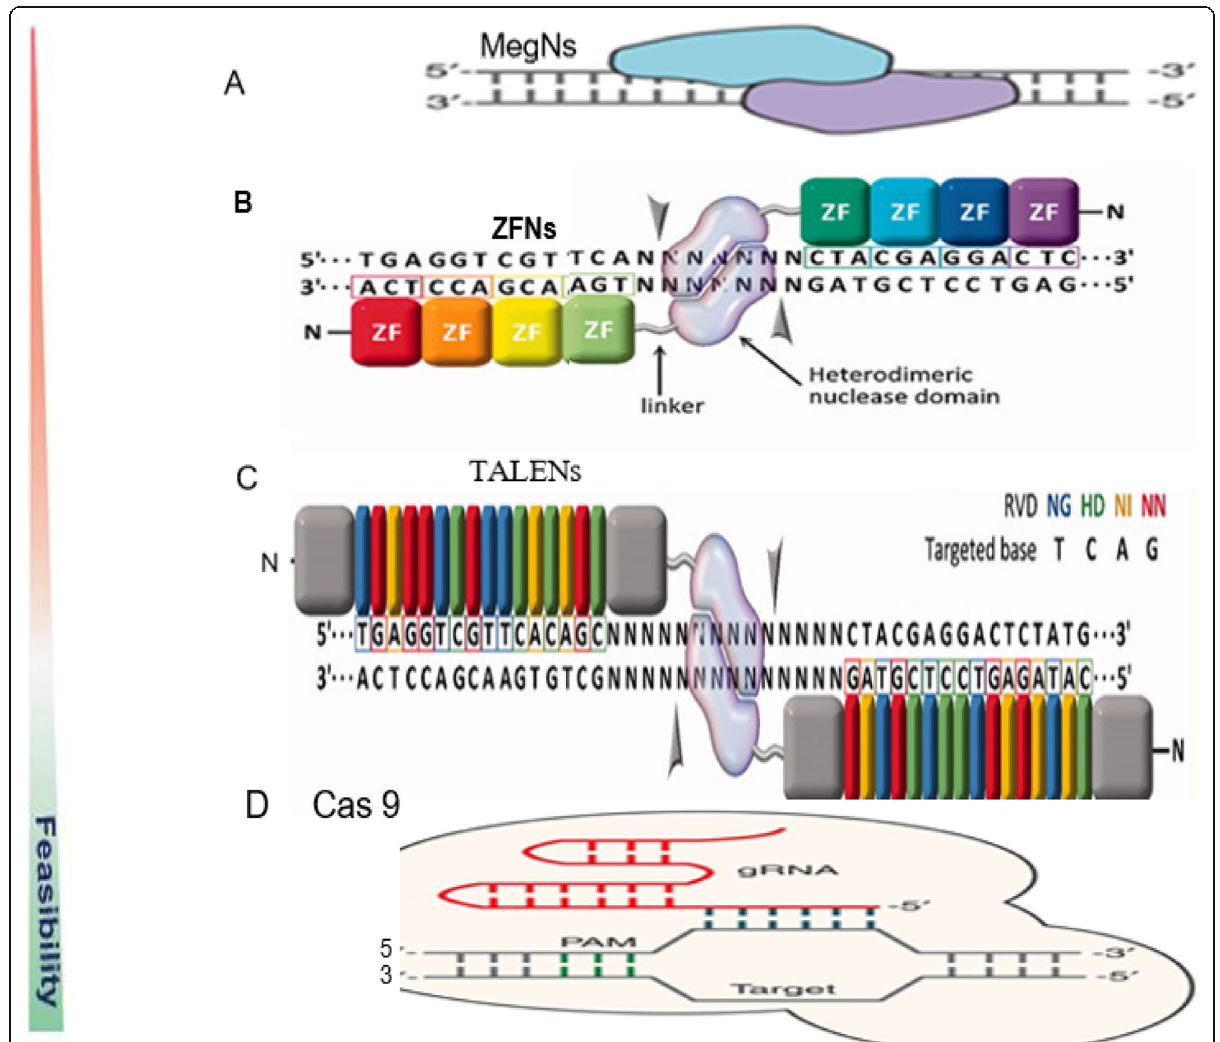
Fig. 2 Schematic diagram of the four endonucleases used in gene editing technologies. a Meganuclease (MegN) that generally cleaves its DNA substrate as a homodimer. b Zinc finger nuclease (ZFN) recognizes its target sites which is composed of two zinc finger monomers that flank a short spacer sequence recognized by the FokI cleavage domain. c Transcription activator-like effector nuclease (TALEN) consists of two monomers; TALEN recognizes target sites which flank a fok1 nuclease domain to cut the DNA. d CRISPR/Cas9 system is made of a Cas9 protein with two nuclease domains: human umbilical vein endothelium cells (HuvC) split nuclease and the HNH, an endonuclease domain named for the characteristic histidine and asparagine residue, as well as a single guide RNA (sgRNA). (Adapted from [1, 51]; Gaj et al., 2016